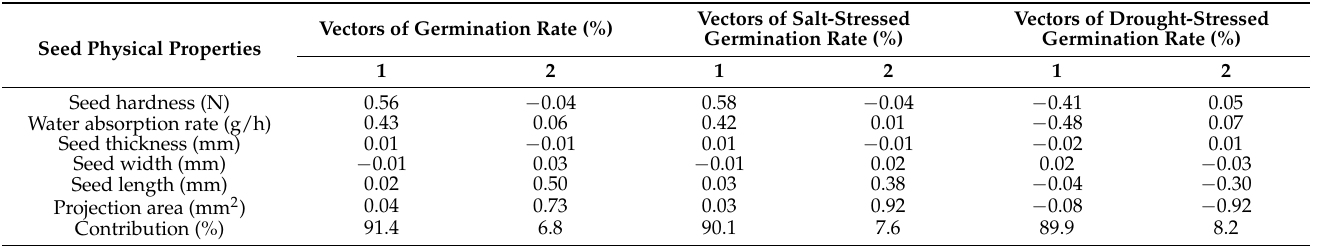
Table 4. Principal component analysis between seed vigor indicators and seed physical properties of rice cultivars collected from different